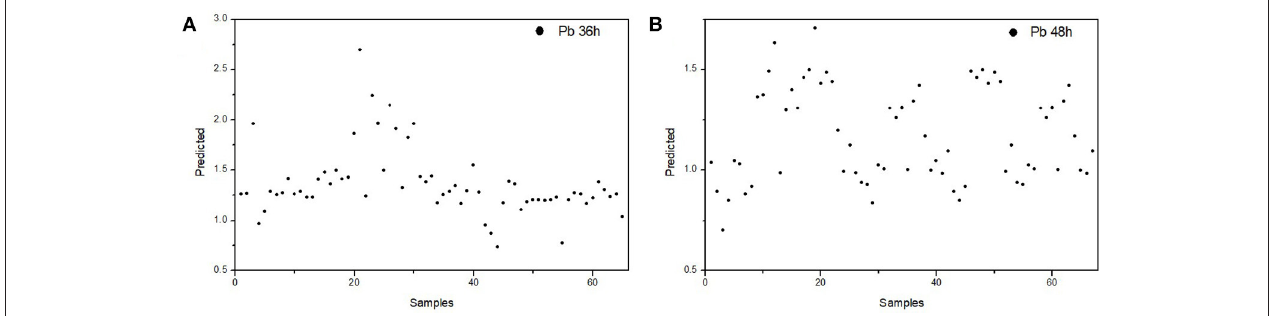
FIGURE 9 | Discrimination of the rats suffering from different extents of ALP using the proposed PLS-DA model: (A) 36h post-injection; (B) 48h post-injection.